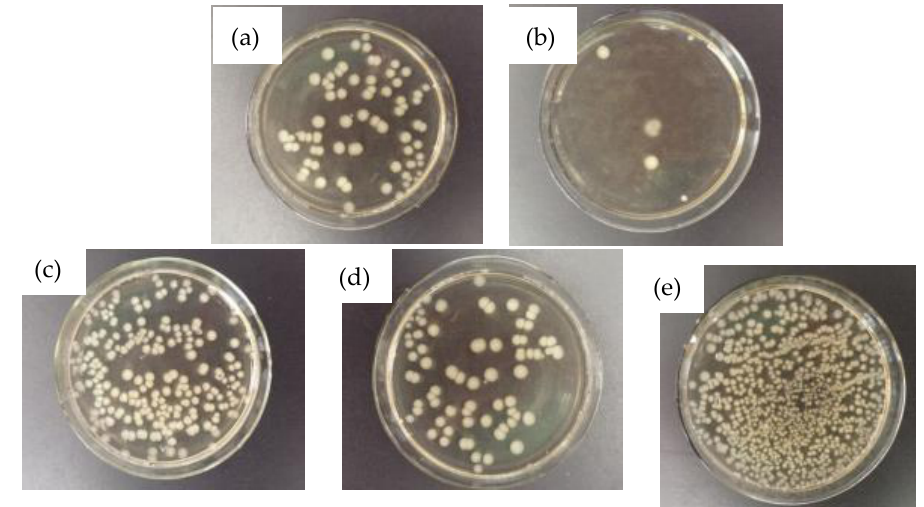
Figure 10. The bactericidal effect of maps of the samples after 24 h interaction with the bacterial solution: ( a ) SX-650; ( b ) SX-750; ( c ) SX-850; ( d ) SX-950; ( e ) 2205.